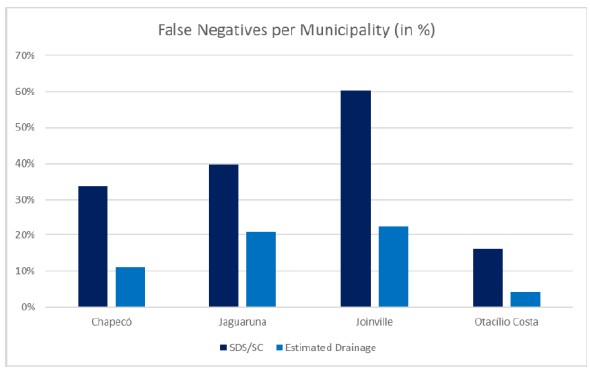
Figure 7 – False Negatives per Municipality (in